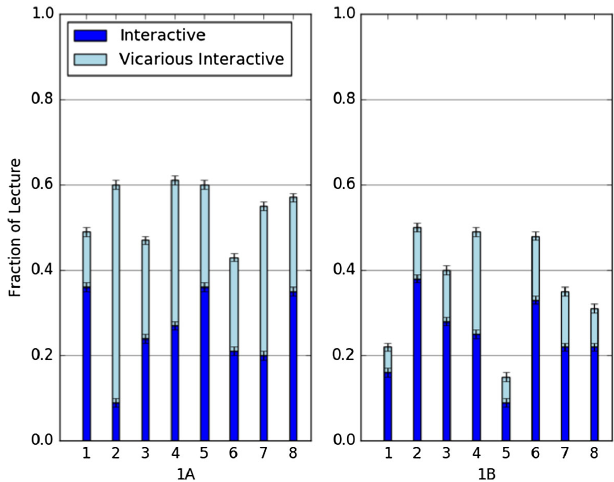
FIG. 1. Fractional time spent on interactive and vicarious interactive activities for 1A and